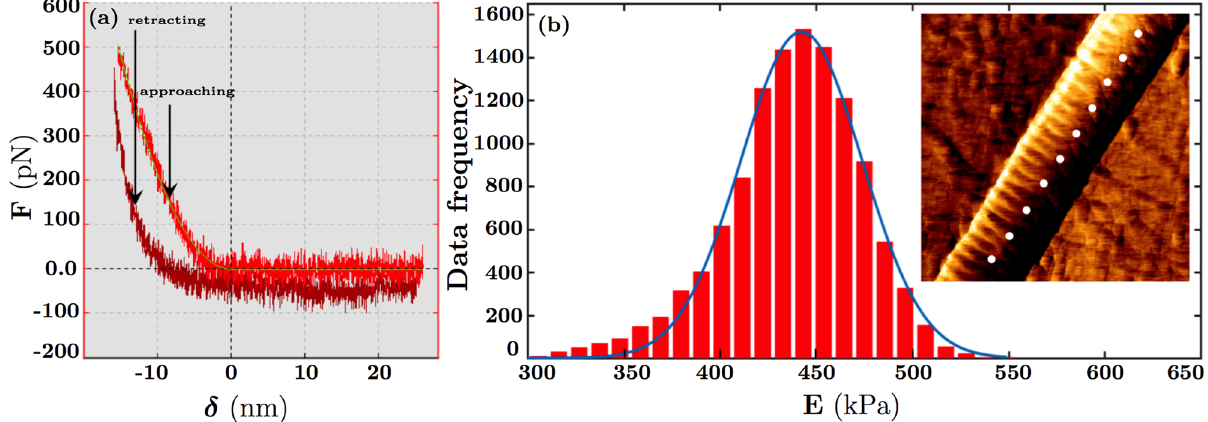
Figure 7. Representative atomic force microscopy results. ( a ) Schematic of the vertical deflection extend, F, in terms of the tip-sample separation, δ ; ( b ) Plot of the Gaussian distribution versus the elastic modulus, E, for fibrils with the ratio of tropocollagen I/tropocollagen III = 9:1 in Phosphate Buffered Saline (PBS) solution (The red diagram denotes the histogram of the data, and the blue curve represents the fitted Gaussian curve). A representative force map including some indentation points on a collagen fibril is